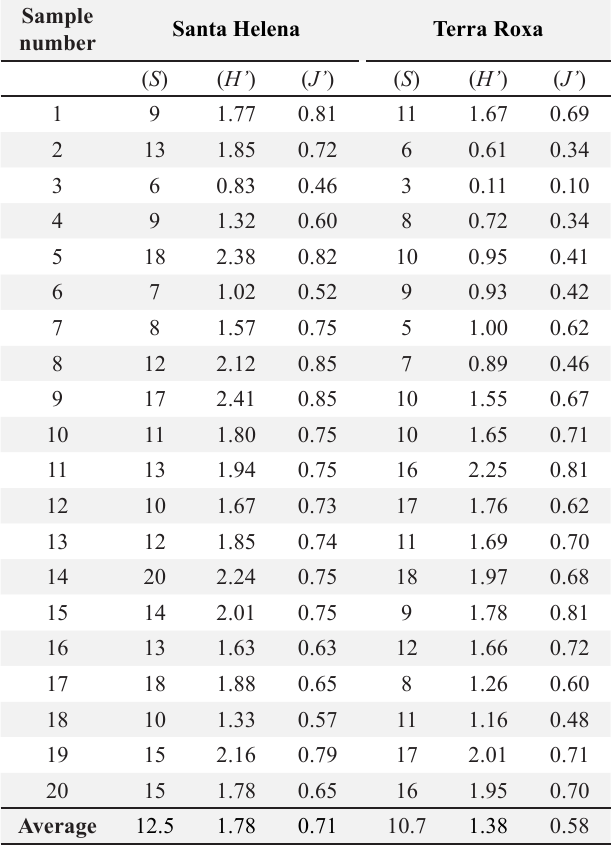
Table 4. Number or richness (S), and diversity (H ‘), and evenness (J’) indexes of the pollen types found in each honey sample from the counties from Santa Helena and Terra Roxa,